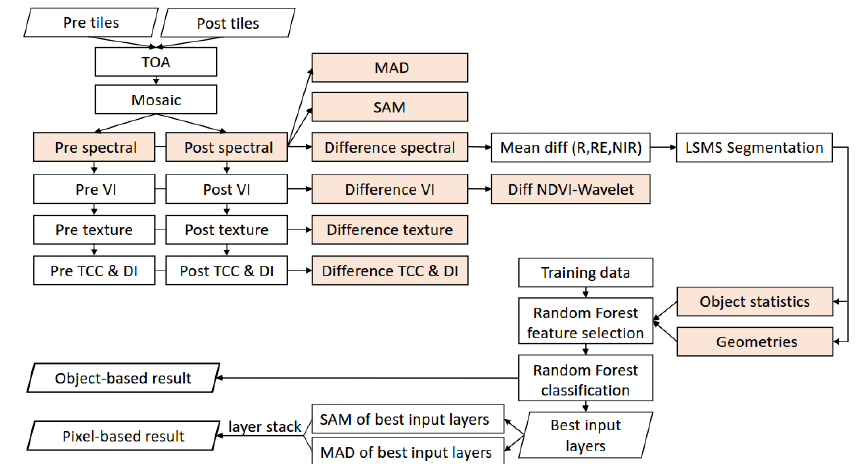
Figure 2. Flowchart of the developed windthrow analysis procedure. Input features for Random Forest are highlighted (orange). Abbreviations: TOA (Top Of Atmosphere correction), VI (Vegetation Indices), MAD (Multivariate Alteration Detection), SAM (Spectral Angel Mapper), TCC (Tasseled Cap Coefficients), DI (Disturbance Index), LSMS (Large-scale Mean Shift), NDVI (Normalized Difference Vegetation Index), NIR (Near Infrared), R (Red), and RE (Red Edge).